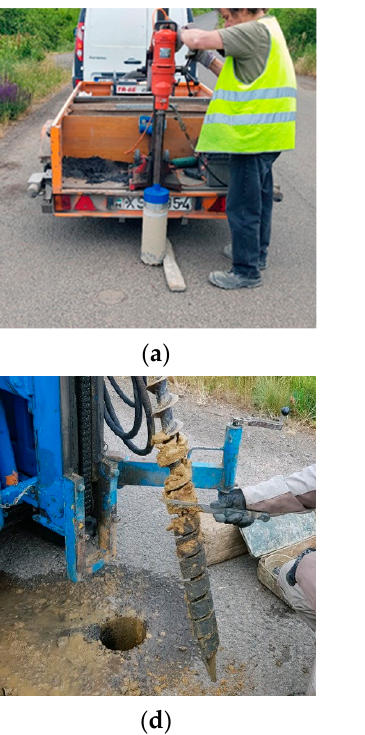
Figure 16. In-site destructive evaluation of pavement structural properties. ( a ) Rotary pavement coring; ( b ) asphalt and CTB field cores; ( c ) breakthrough old macadam; ( d ) sample of the subgrade soil; and ( e ) the schema of the reconstructed pavement types.